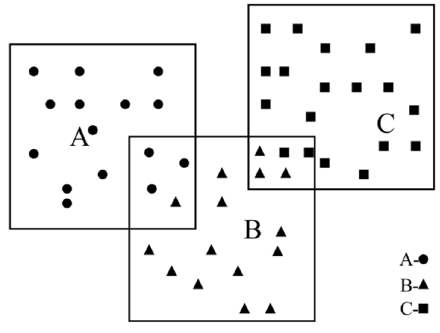
Figure 15. Algorithm full coverage processing frame generation algorithm flow.